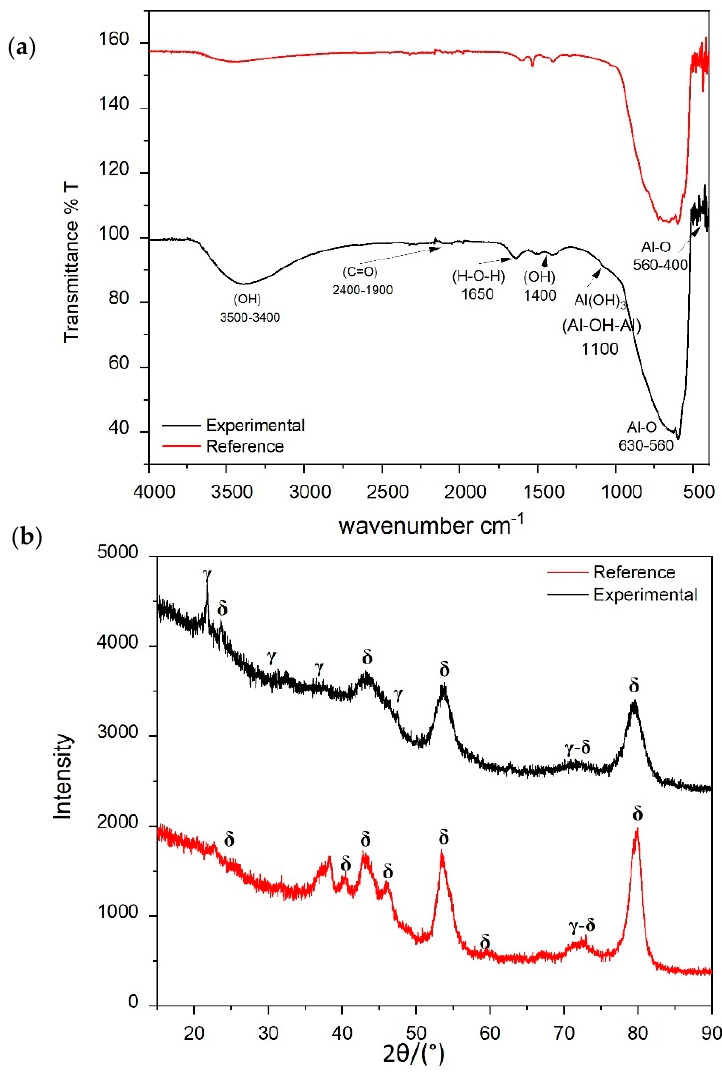
Figure 4. Comparative ( a ) FT-IR spectra of the synthesized Al 2 O 3 and a commercial reference (Sigma Aldrich)—transmittance in a.u. (arbitrary unit)—and ( b ) XRD pattern.